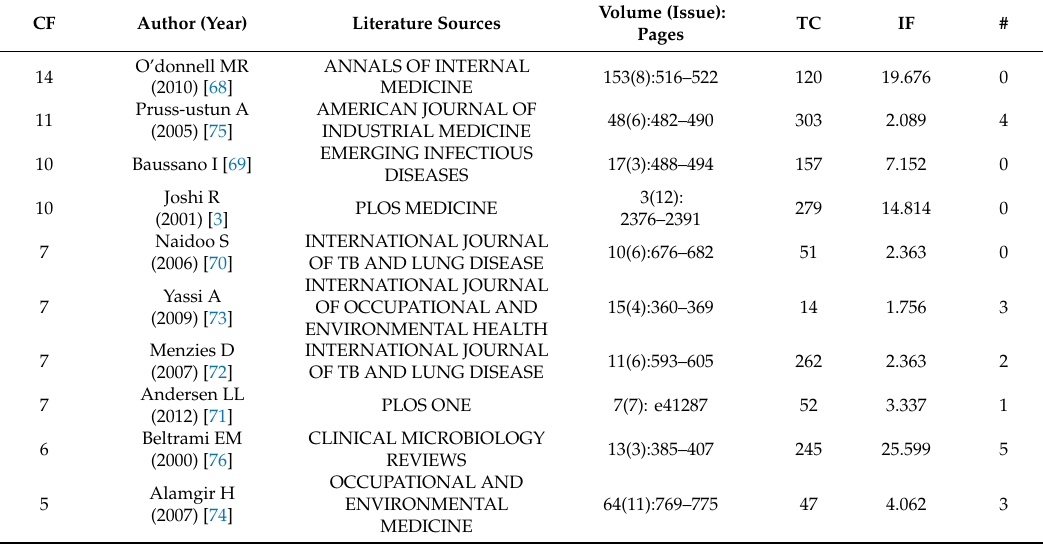
Table 5. Top 10 Most Frequently Cited Articles During